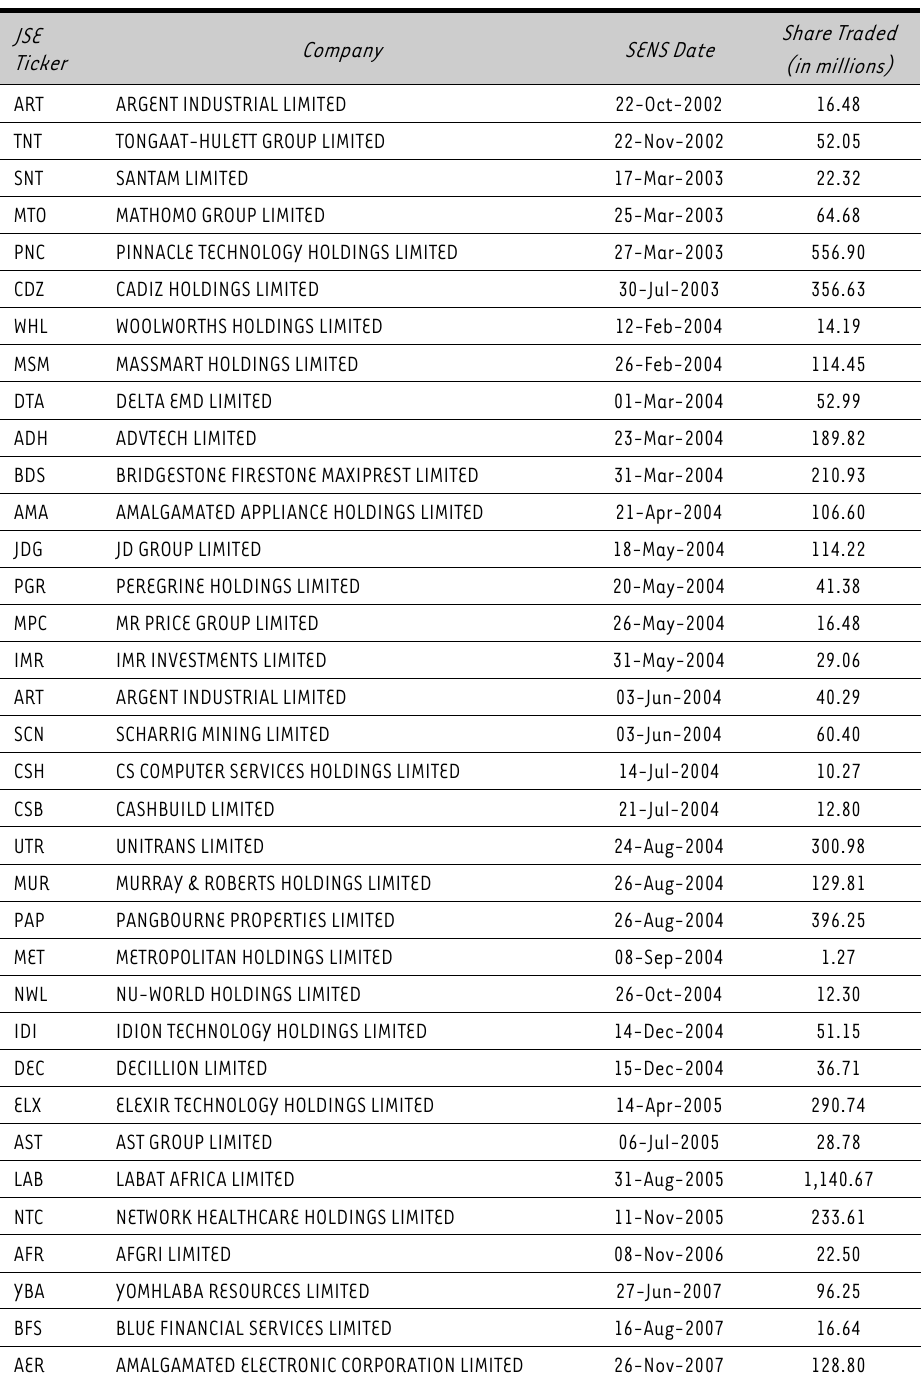
Chronological distribution of financial